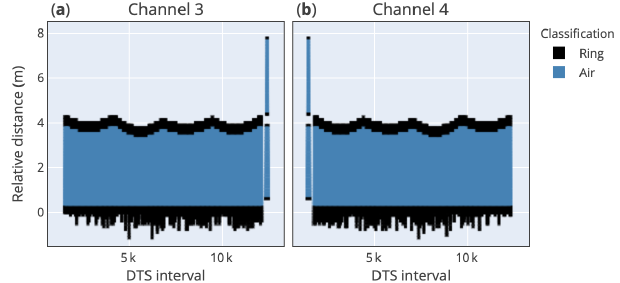
Figure A2. The distance relative to the lower support rings were determined for DTS intervals in (a, b) opposite sensing directions. Intervals in contact with the rings were excluded from the analysis, leaving 8286 usable locations.